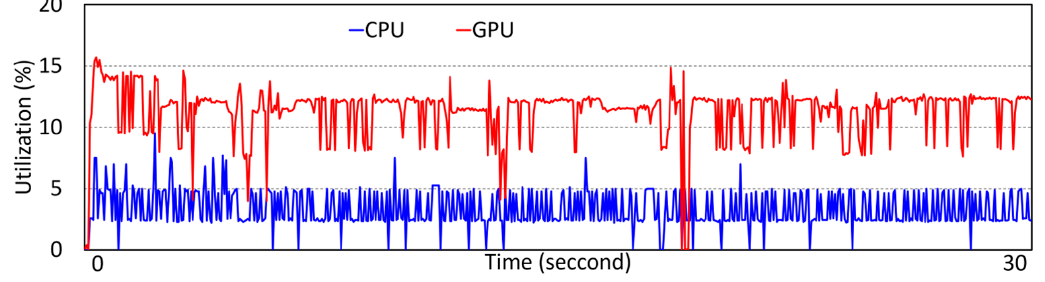
Figure 3. Variation in CPU and GPU utilization during scrolling.